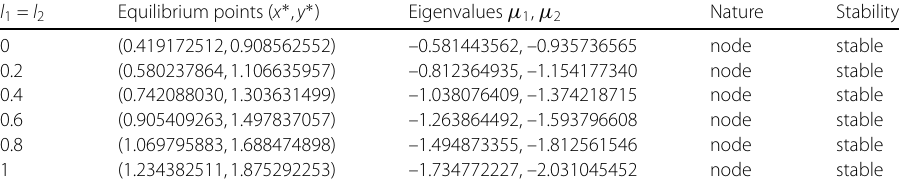
, F ( y ) = L – y K + Dx L + Dy